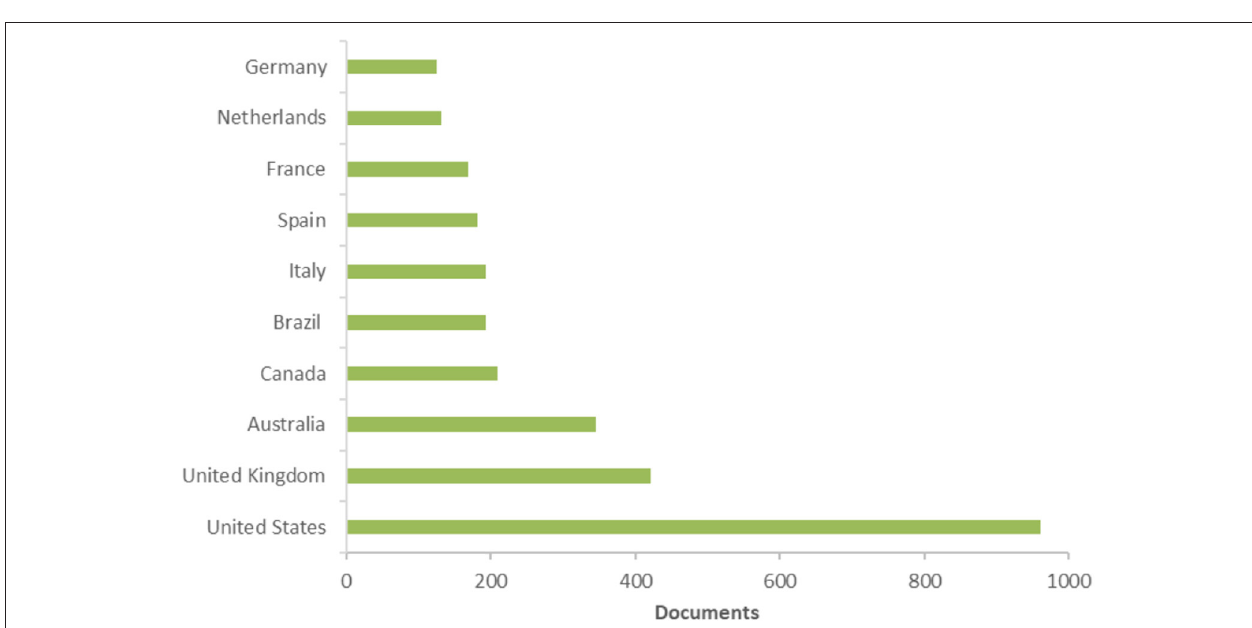
FIGURE 2 | Most productive countries/territories. Based on data from